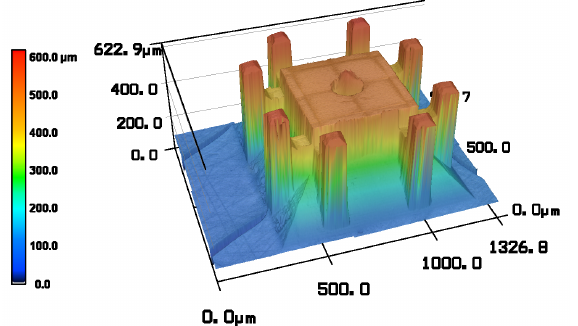
Figure 6. Metrology of the final picking head